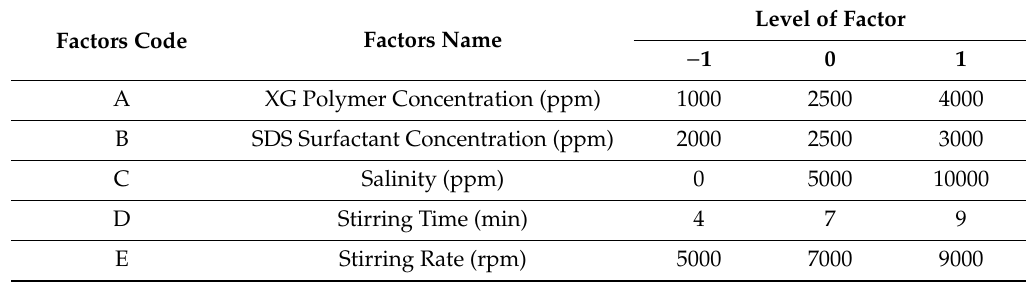
Table 1. Independent factors and their levels in definitive screening design (DSD).